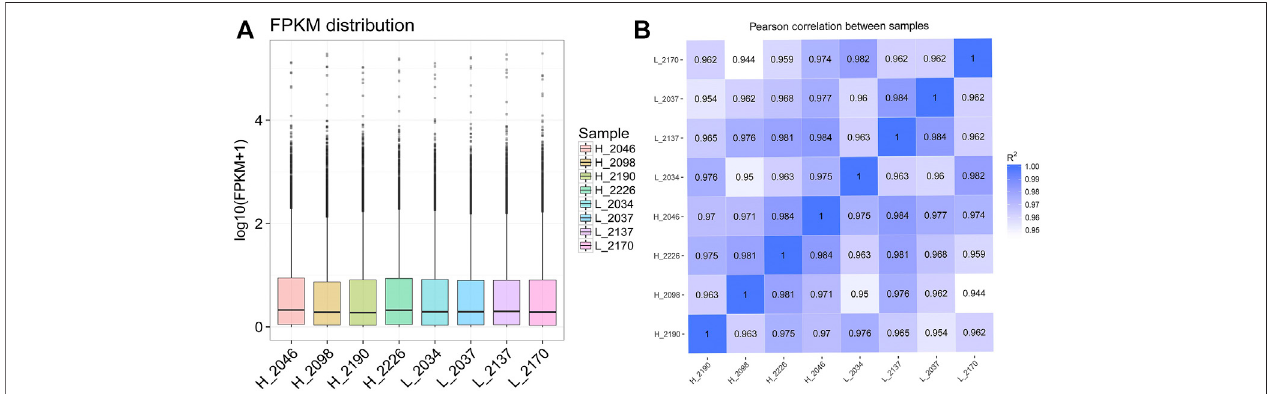
FIGURE3| Expressionleveldistribution andcorrelationanalysisofeachsample. (A) :Theboxdiagramofdifferentsampleexpressionvalues,inwhichtheabscissa isthesamplenameandtheordinateislog10(FPKM+1).Theboxdiagramofeachregioncorrespondsto fi vestatistics(fromtoptobottom,themaximum,upperquartile, median, lower quartile, and minimum). (B) : The heat maps for the correlation analysis between samples. FPKM, Fragments per kilobase of exon per million fragments mapped, R 2 , Pearson correlation coef fi